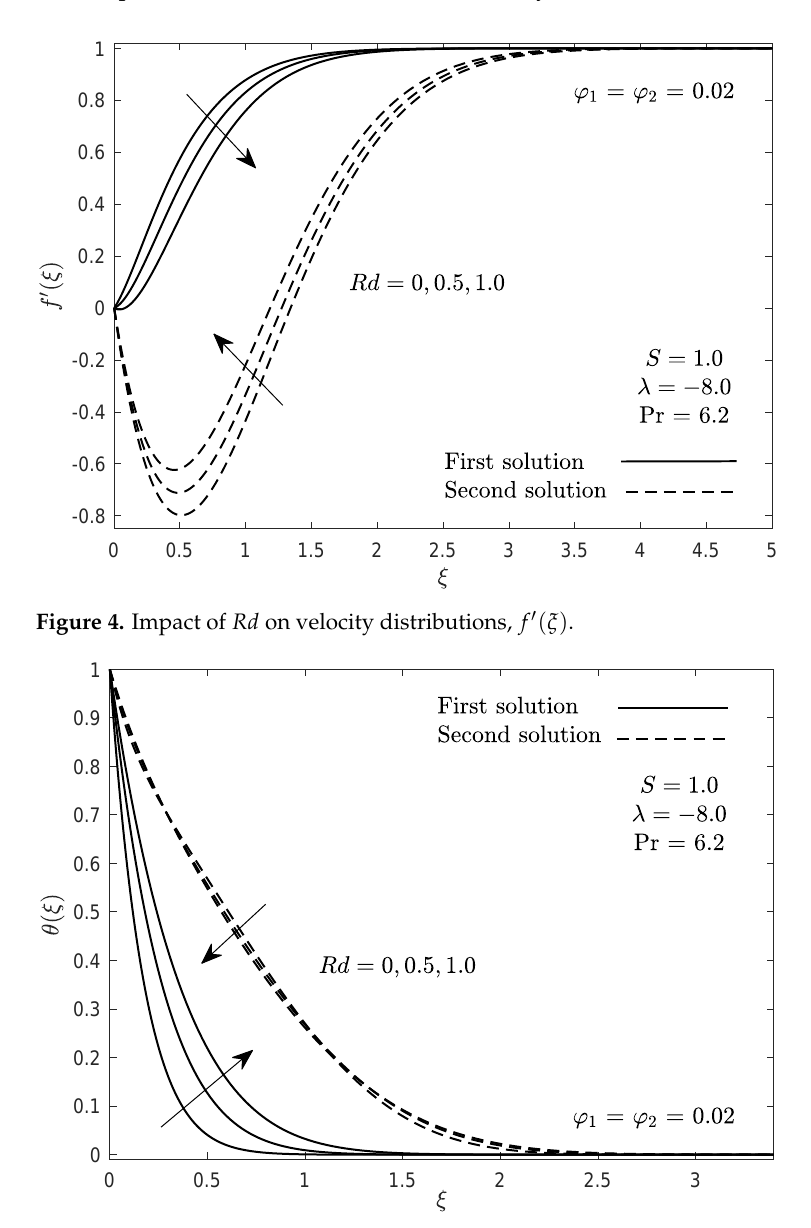
Figure 5. Impact of Rd on temperature distributions, θ ( ξ )